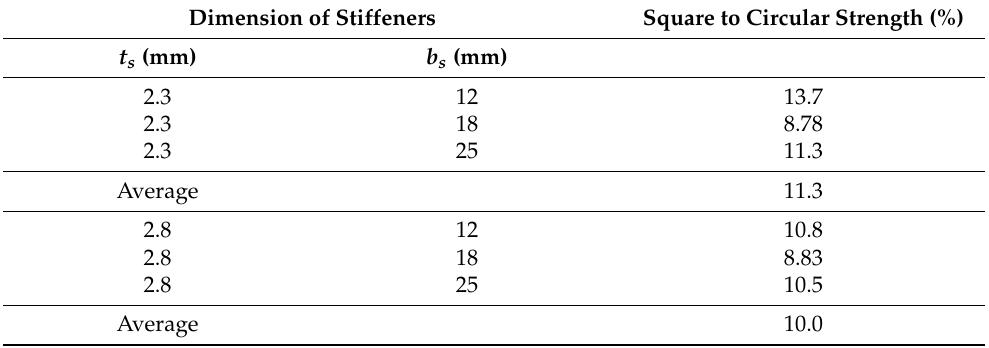
Table 11. The difference in the strength of stiffened square CFDST and stiffened circular